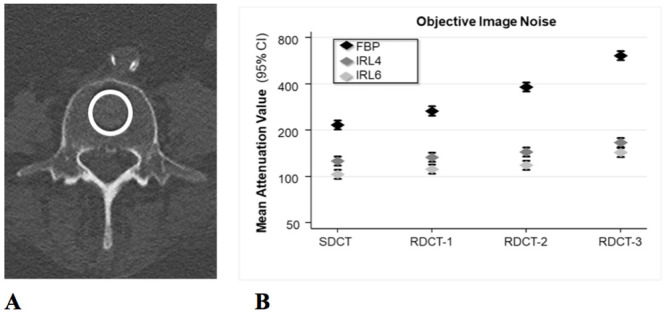
Objective image noise.A Measurement of CT number and objective image noise (OIN). Axial CT image shows placement of ROI (circle) in the center of the body of the third lumbar vertebra. Measurements were performed in three adjacent slices and the mean values were calculated. B Quantitative analyses of OIN (defined as SD of CT number) for SDCT and three different RDCT protocols, as measured in the center of the body of the third lumbar vertebra. Images were reconstructed with FBP and IRL4 and IRL6. Horizontal midpoints of diamonds represent mean values, and error bars denote 95% CIs. Compared to SDCT with FBP, even the RDCT protocol with lowest dose (RDCT-3) reconstructed with IR resulted in lower OIN.